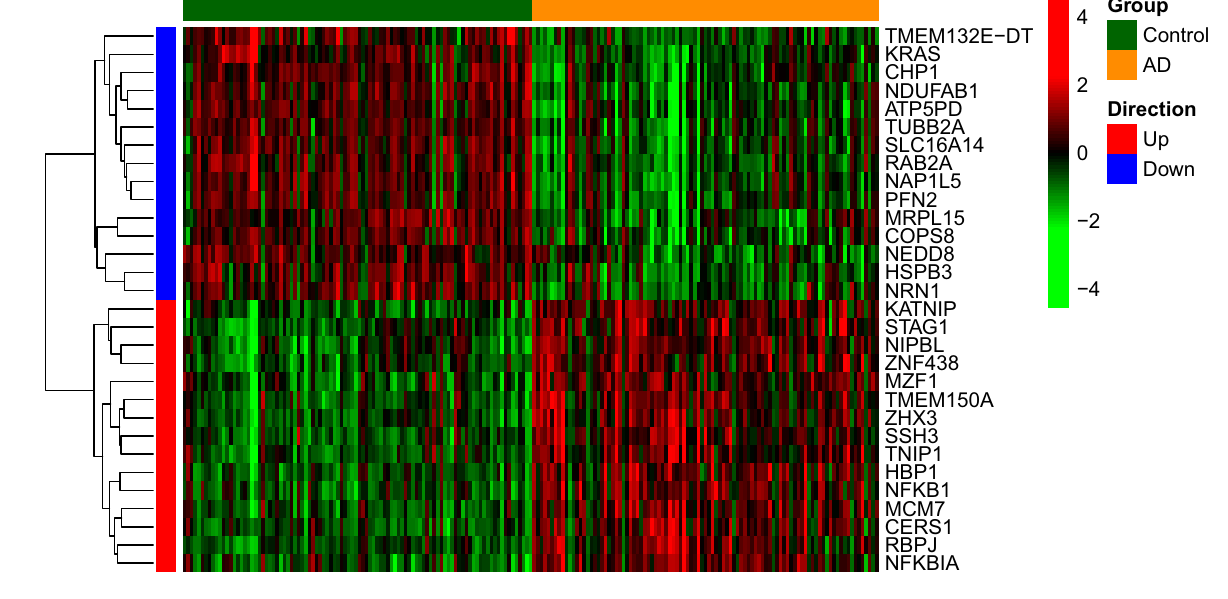
Figure 2. Heatmap of differentially expressed genes (DEGs) between AD patients and controls from the GEO database.